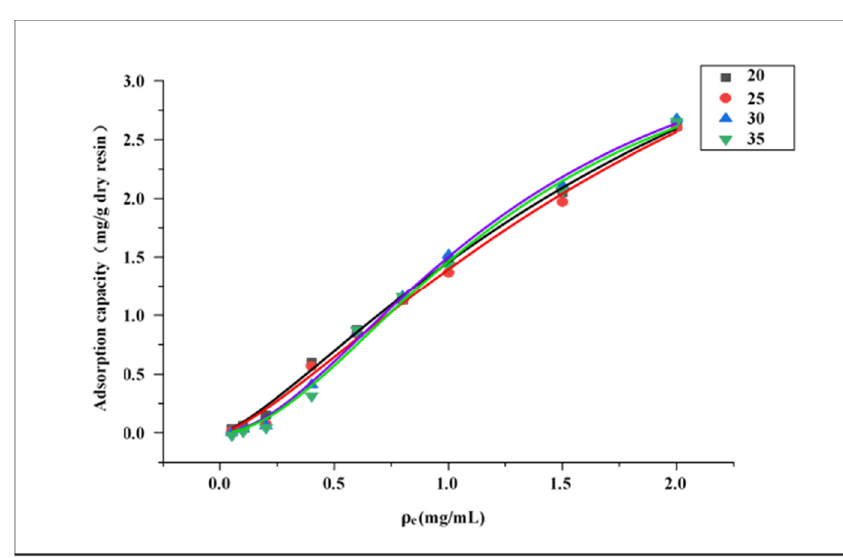
Figure 6. Static adsorption kinetics.